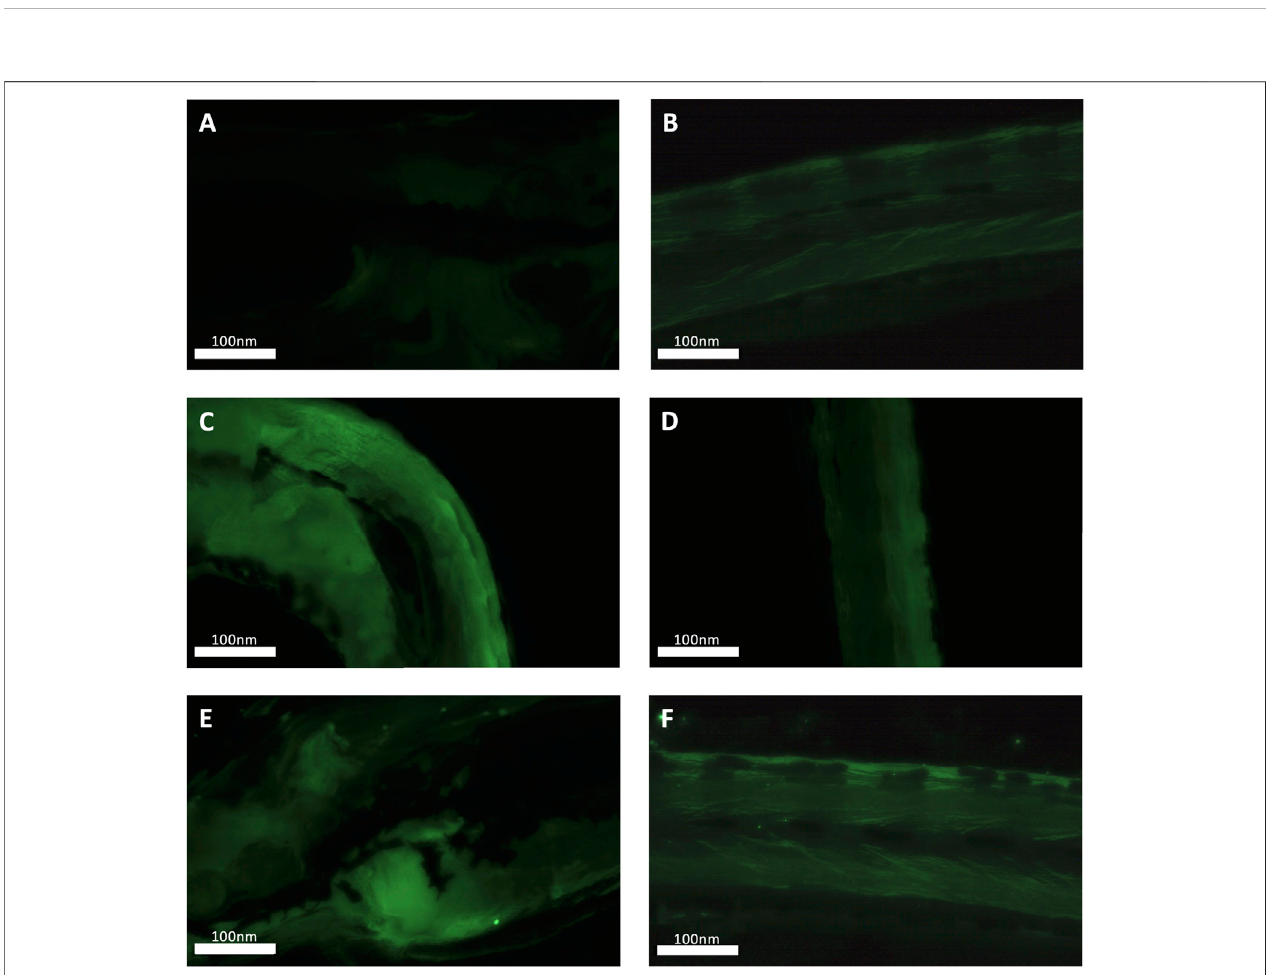
FIGURE 2 | Fluorescence microscopy-based validation of nanoplastic uptake in control, 2.5 and 25 ppm fl uorescent polystyrene nanoplastic particle exposed zebra fi sh. Representative head and tail images of control (A,B) , low PS (C,D) and high PS exposure group (E,F) 7 dpf zebra fi sh larvae are shown.